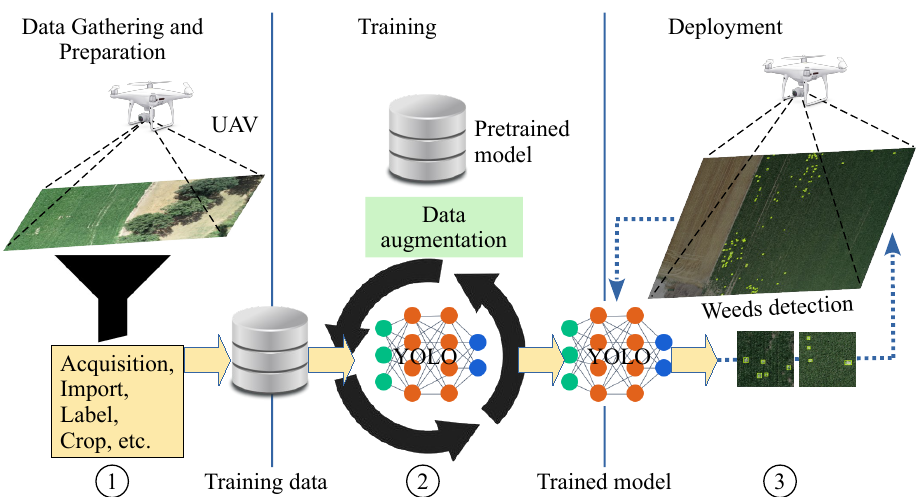
Figure 1. The general process of training and generalization for weed detection. The weed detection process consists of three steps: (1) the acquired images are labeled using the Roboflow tool and then cropped to match the format for the YOLOv7 model; (2) the YOLOv7 detector uses these labeled images for the training process; and (3) the trained model detects weeds in the input images, and a final output map of weeds can be